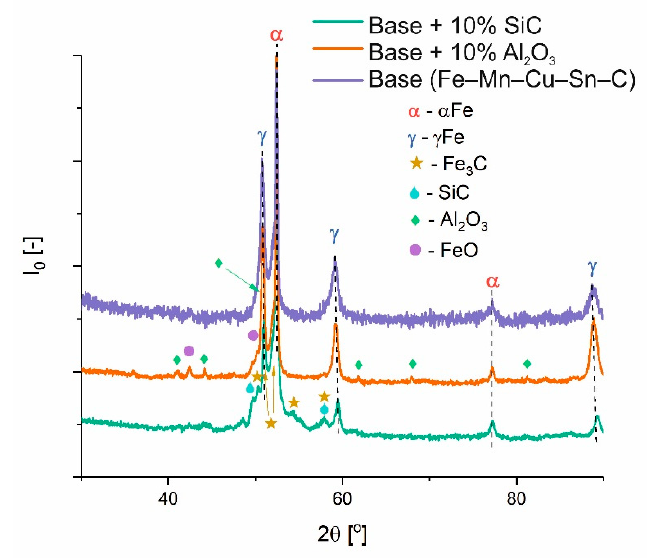
Figure 5. XRD analysis of iron-based composites sintered by SPS at 900 °C.